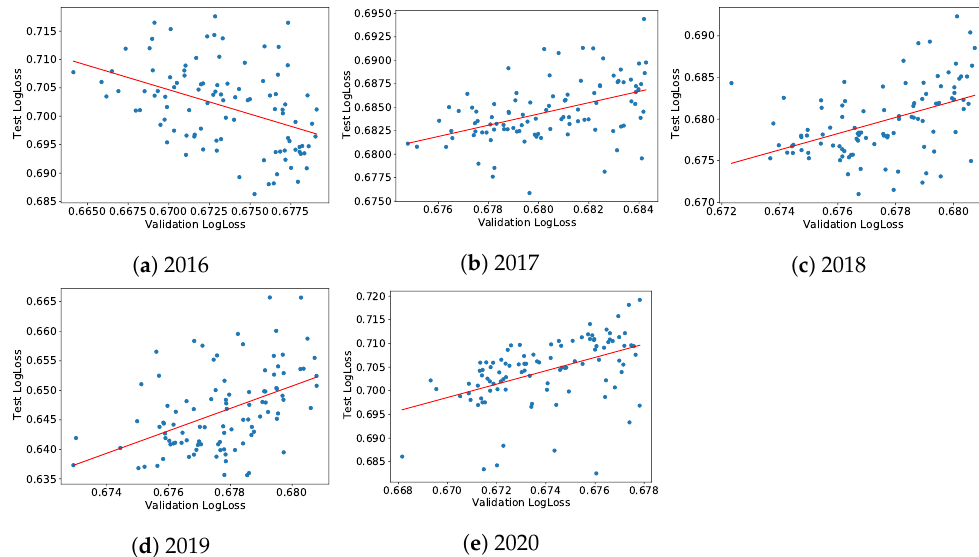
Figure A2. Standard temporal split: test set cross-entropy versus validation cross-entropy of the 100 best models of the random hyperparameters